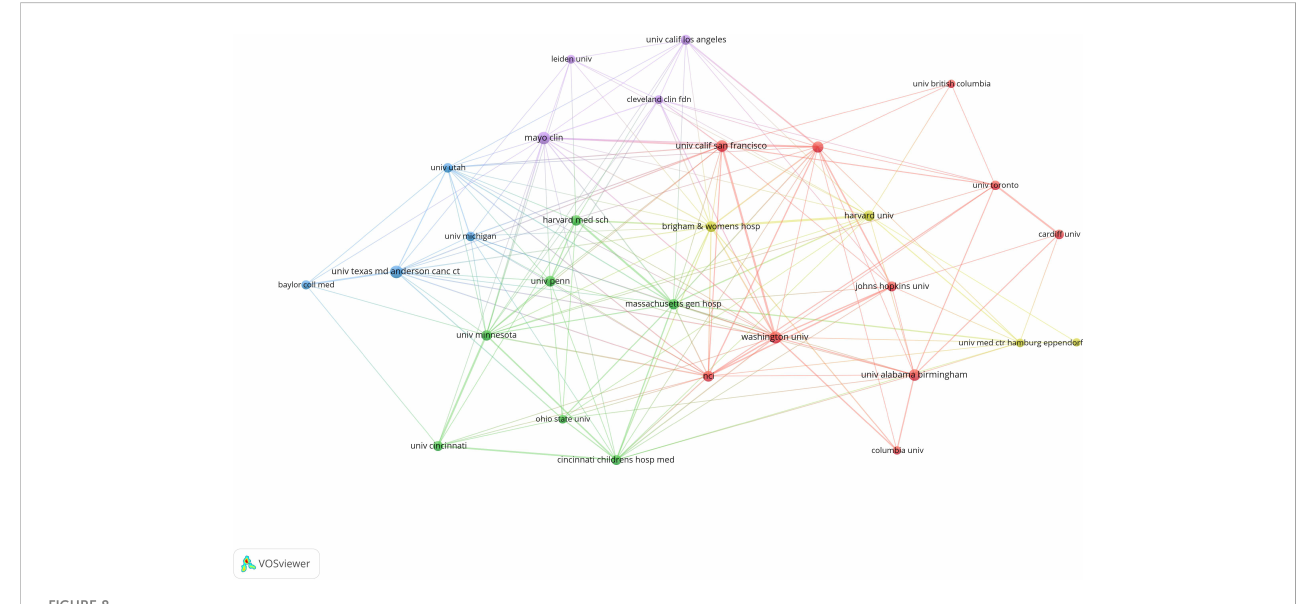
FIGURE 8 Visualization of collaborations between institutions